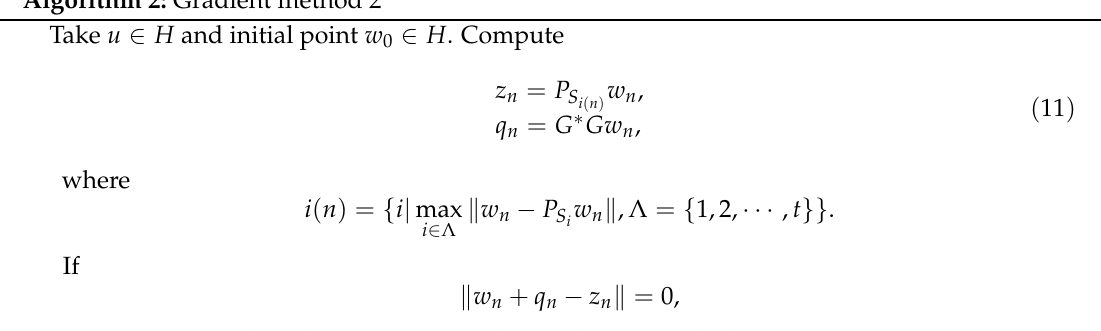
Algorithm 2: Gradient method